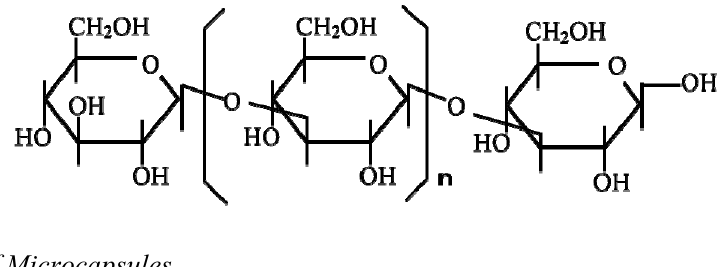
Figure 1. Molecular structure of Curdlan.